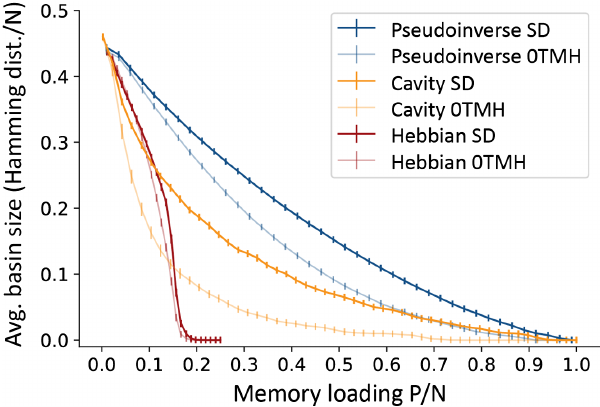
FIG. 13. Average basin size of patterns stored in a CCQED system as a function of P=N using the linear transformation encoding scheme (yellow line). Results are shown for N ¼ 800 ; however, similar results are found forsystem sizesof N ¼ 50 – 800 . For comparison, the average basin sizes are plotted for the Hebbian (red line) and pseudoinverse (blue line) learning methods. In each case, we show the results of both SD (more intense lines) and 0TMH (less intense lines) dynamics; w ¼ 1 . 5 w 0